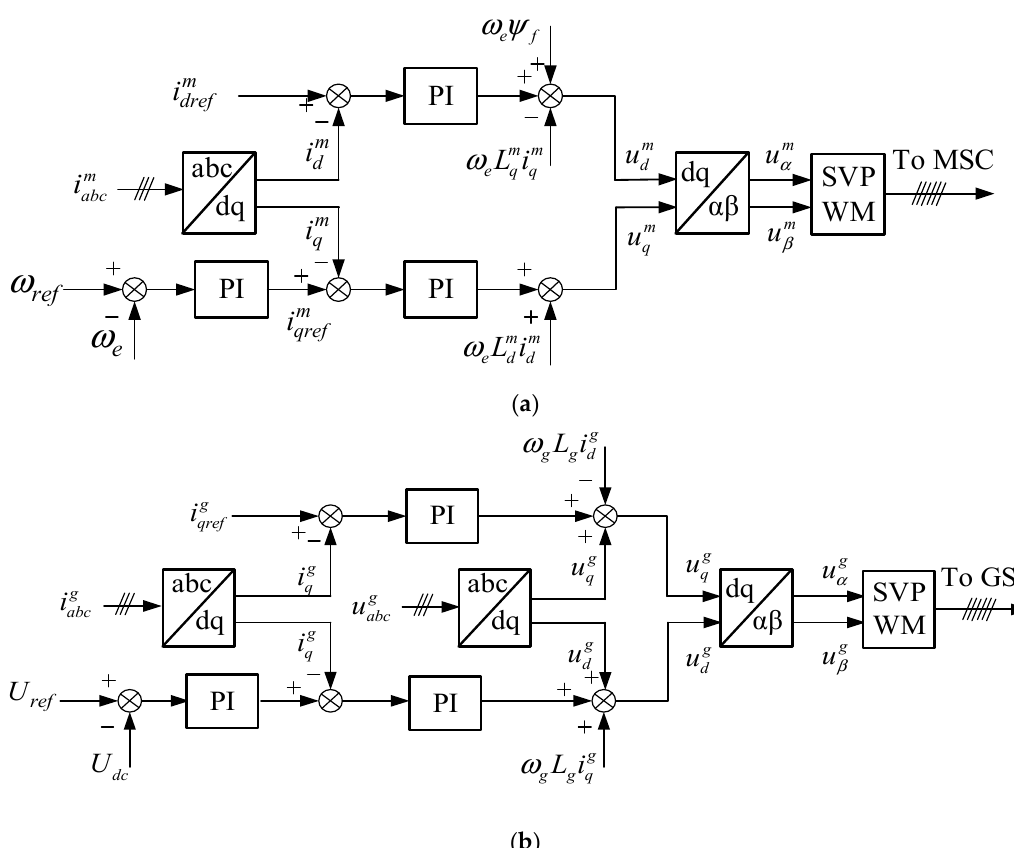
Figure 5. Control diagram of back-to-back converter ( a ) motor-side; ( b ) grid-side.